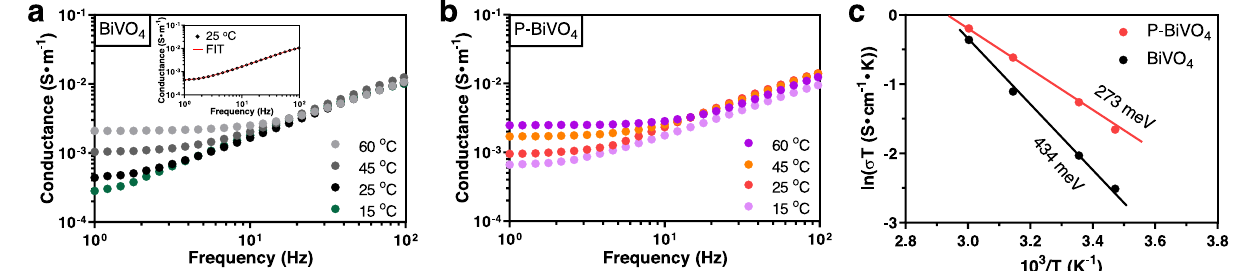
Fig. 5 | Temperature-dependent conductance of the BiVO 4 and phosphorus- doped BiVO 4 samples. Real part of conductance plots measured at different temperatures in the dark with a bias voltage of 0.6V RHE for a pristine BiVO 4 and b phosphorus-doped BiVO 4 in the electrolyte of 0.1M KPi buffer solution